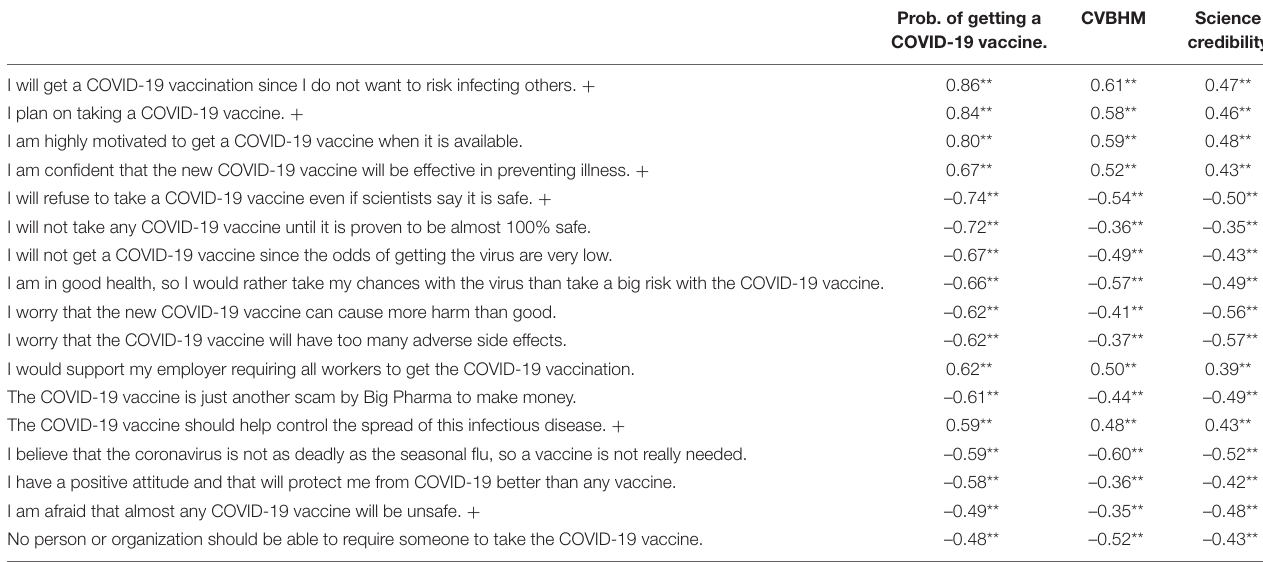
Prob. of getting a CVBHM Science COVID-19 vaccine.